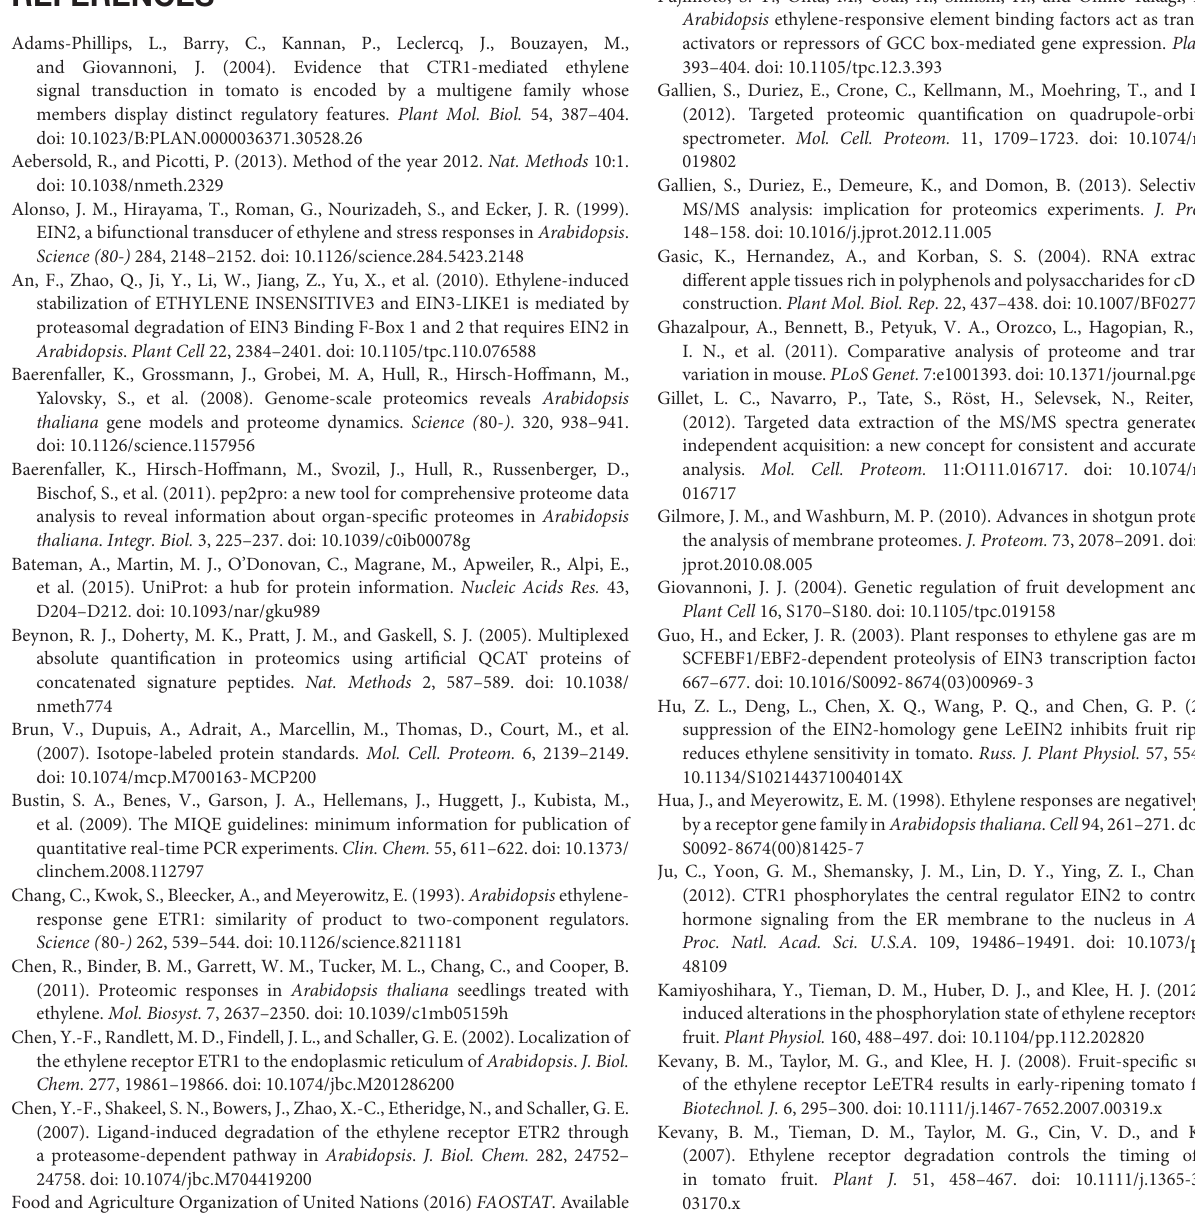
TABLE S2 | Selected results output of the use of the mProphet algorithm of the targeted peptide identifications trained with the second best peak option. TABLE S3 | RT-qPCR primers for the 12 ethylene signaling and 3 reference genes used in this study. Primers were designed with the Primer3 web tool (http://bioinfo.ut.ee/primer3/). Primer specificity was checked by BLAST-ing against all tomato EST’s and known cDNA sequences. TABLE S4 | Amino acid sequences of the proteins SlETR1-SlETR7, SlCTR1-SlCTR3 and SlEIN2 obtained from Uniprot (Bateman et al., 2015). Their